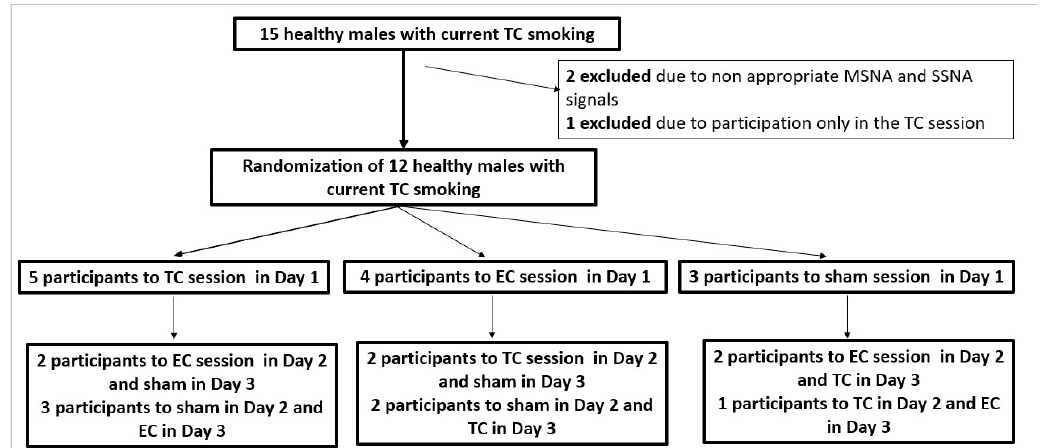
Figure 1. The study design illustrating the randomization to TC, EC and sham smoking sessions in random order, each session on a separate day. EC, electronic cigarette; MSNA, muscle sympathetic nerve activity; SSNA, skin sympathetic nerve activity; TC, tobacco cigarette.